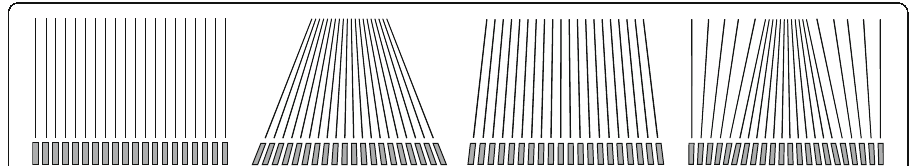
Fig. 1 Illustration of the field of view (FOV) of the discussed collimators. From left to right: parallel hole collimator, cone beam collimator (50 cm), cone beam collimator (100 cm), and multifocal